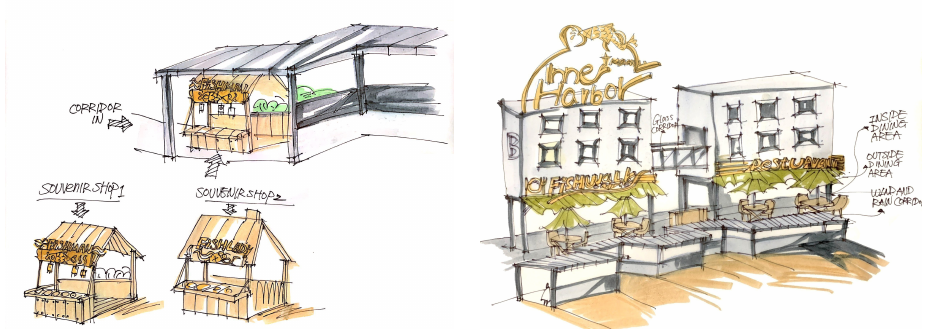
Fig. 10 Sketch of the design concept of commercial